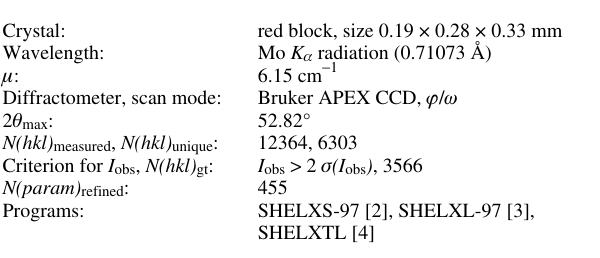
Table 1. Data collection and handling.